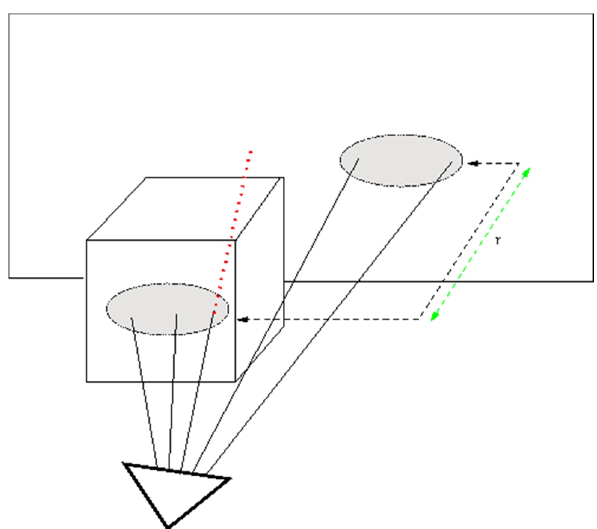
Figure 2. Schematic of local support-based filtering. A 2D scanner is depicted by a triangle. Range measurements from consecutive channels, represented by solid black lines, do not obtain support from each other, if the range difference Δ r is too large. Here, the middle point gets support from its left, but not from its right. On the other hand, the red dotted imaginary beam going through the obstacle would get support from the right, but not from the